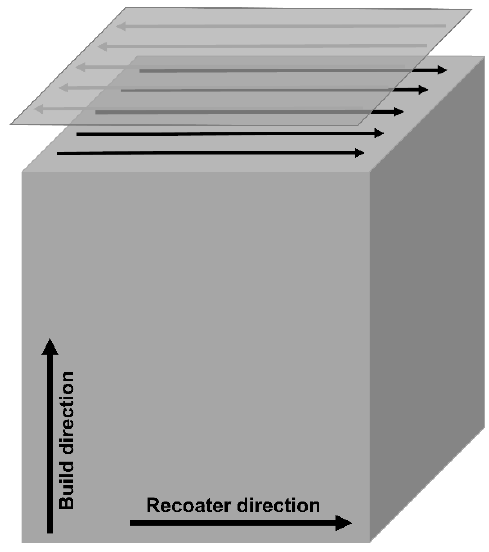
Figure 2. Printing geometry and